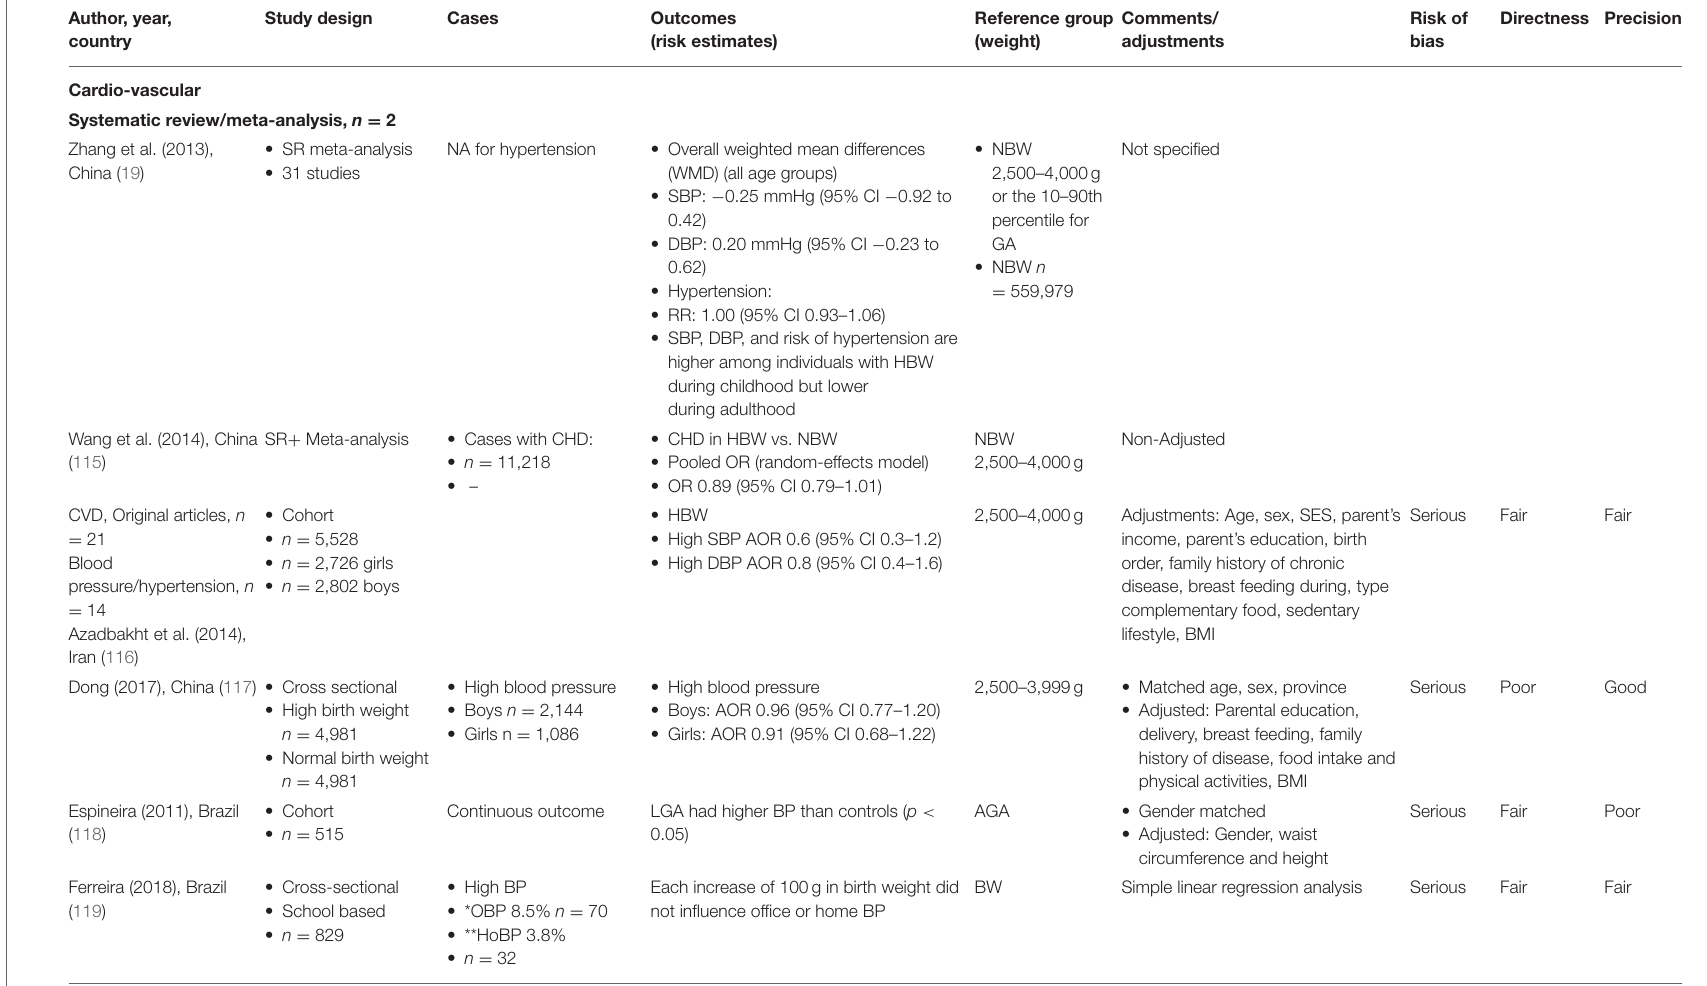
TABLE 1.3 | LGA and high birth weight and long-term outcomes—cardio-vascular